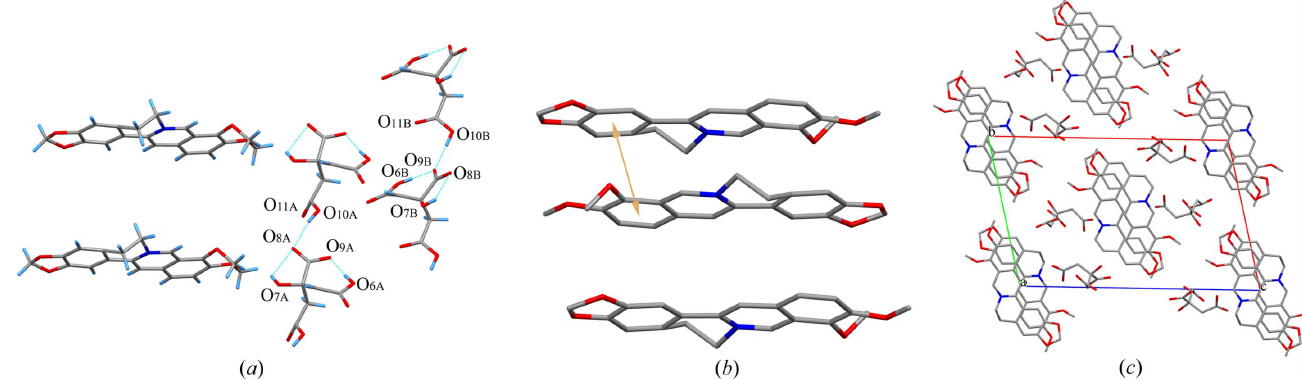
Figure 7 ( a ) Hydrogen bonds between molecules in 2BER-2CA. ( b ) (cid:9) – (cid:9) interactions between molecules in 2BER-2CA (hydrogen atoms have been omitted). ( c ) Three-dimensional structure of 2BER-2CA (hydrogen atoms have been omitted).